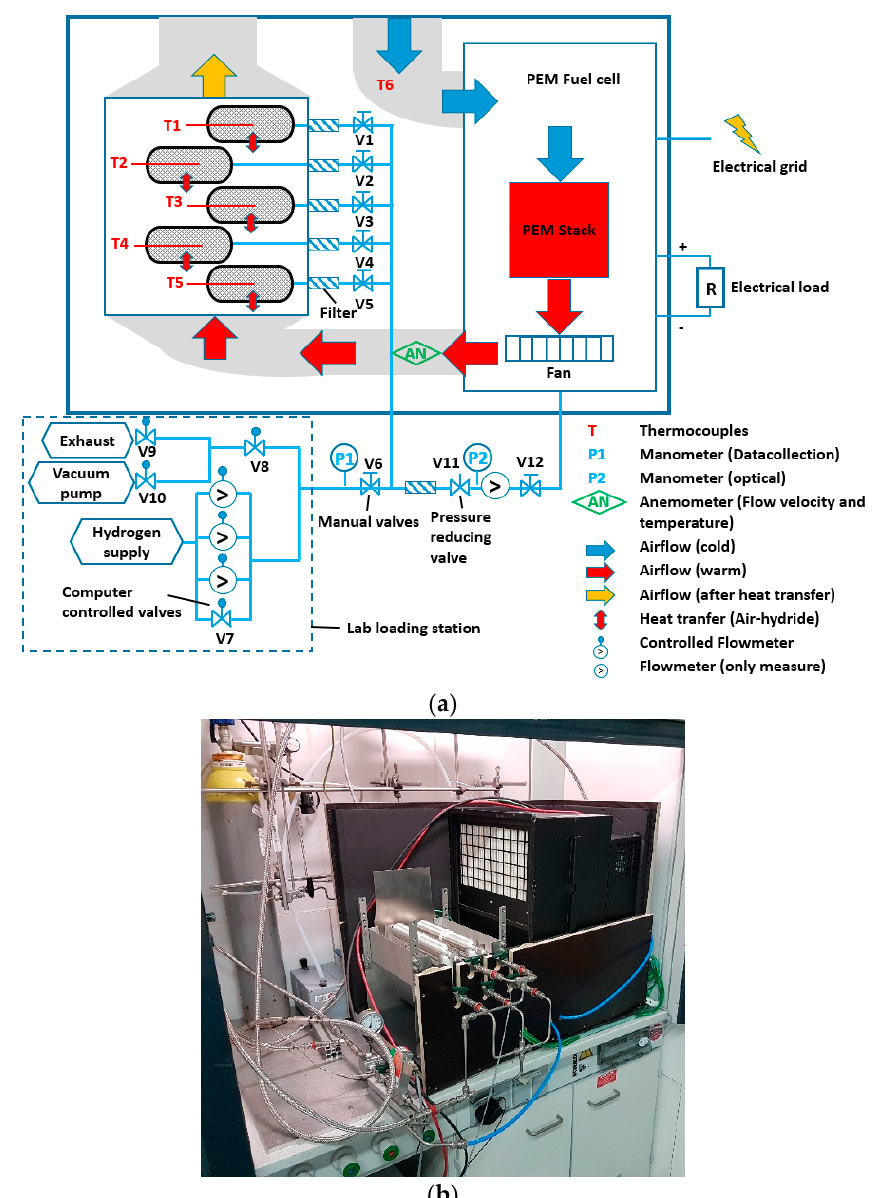
Figure 1. ( a ) Detailed sketch and ( b ) photo of the MH2-Powerbank.